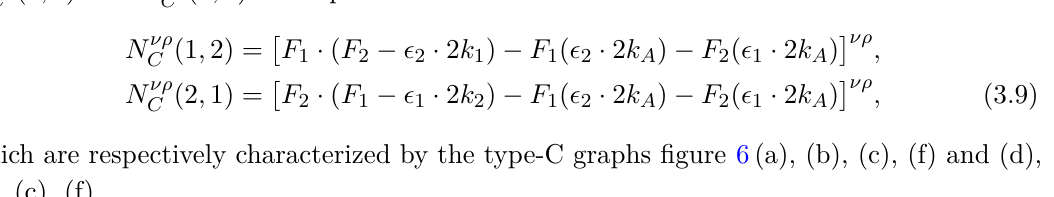
Table 1 . The type-B graphs in figure 5 contributing to each type-B numerator N ρ P (1 , n − 1)